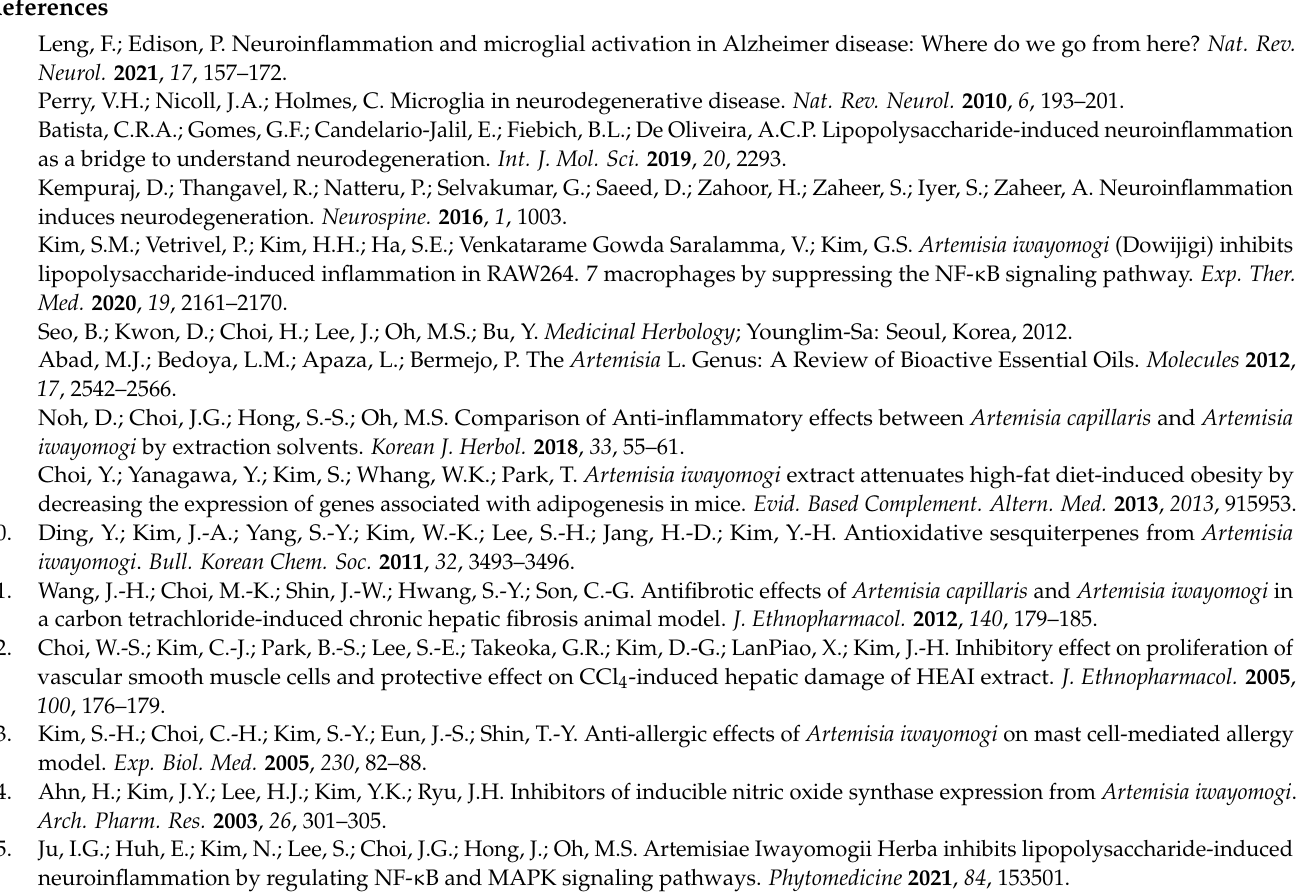
Figure S5. 1 H 13 C HSQC spectrum of compound 1 ; Figure S6. 1 H 1 H COSY spectrum of compound 1 ; Figure S7. 1 H 13 C HMBC spectrum of compound 1 ; Figure S8. 1 H 1 H NOESY spectrum of compound 1 ; Figure S9. HR-DART-MS spectrum of compound 2 ; Figure S10. IR spectrum of compound 2 ; Figure S11. 1 H NMR spectrum of compound 2 (500 MHz, methanol- d 4 ); Figure S12. 13 C NMR spec- trum of compound 2 (125 MHz, methanol- d 4 ); Figure S13. 1 H 13 C HSQC spectrum of compound 2 ; Figure S14. 1 H 1 H COSY spectrum of compound 2 ; Figure S15. 1 H 13 C HMBC spectrum of compound 2 ; Figure S16. 1 H 1 H NOESY spectrum of compound 2